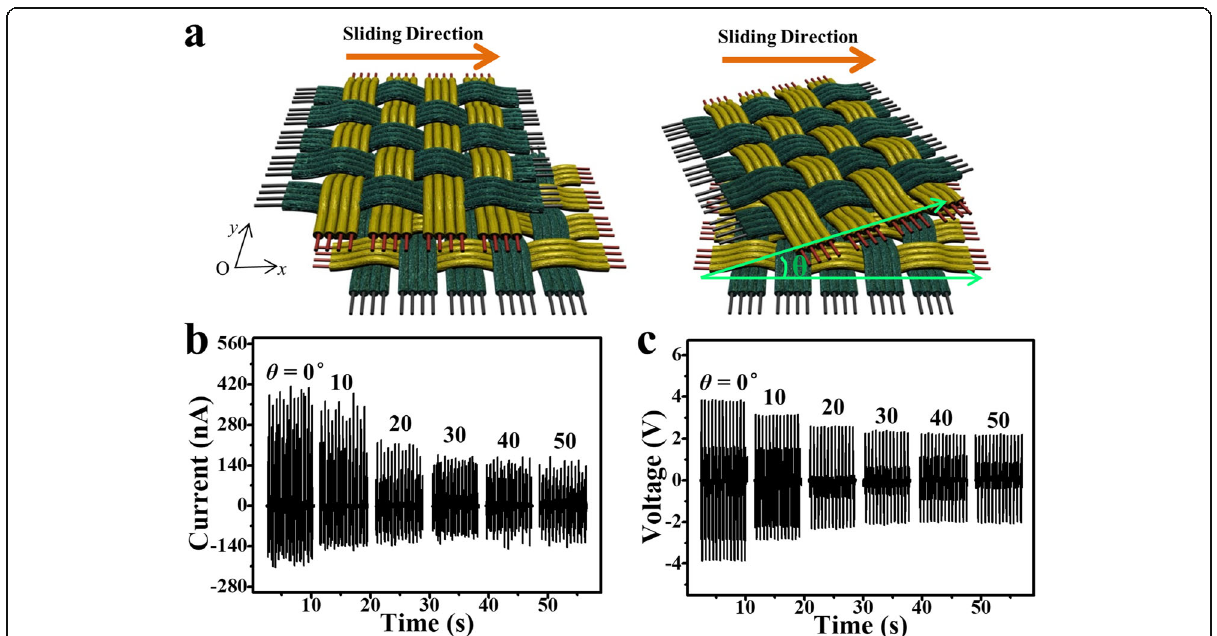
Fig. 4 Adaptability of the 2DW-WTNG working along arbitrary in-plane directions. a Schematic diagram for the 2DW-WTNG working at different relative orientation. b Output current and c output voltage of the 2DW-WTNG at different relative